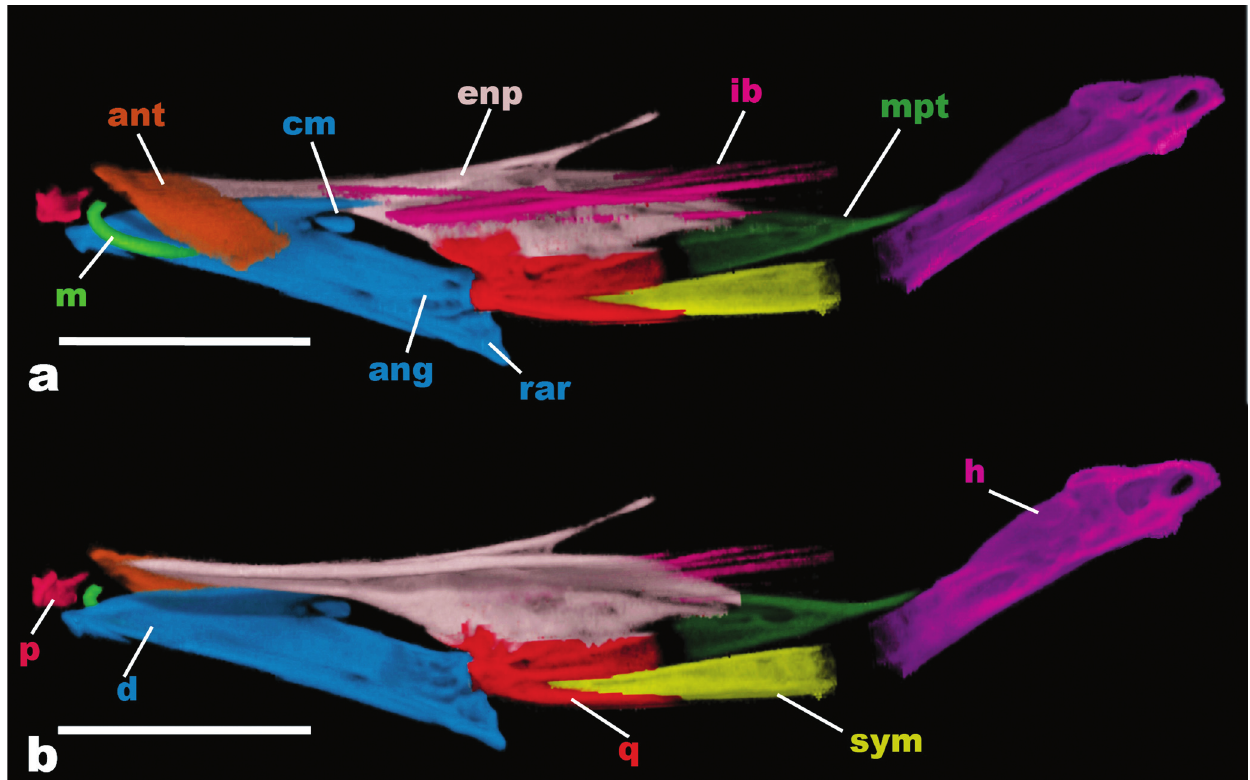
Fig. 5. Suspensorium and oral jaws of the left side of Iracema caiana (MZUSP 49205, 235 mm SL). ( a ) Lateral view; ( b ) Midsagittal view. Anterior to left. Scale bar is 5 mm. Abbreviations: p = premaxilla; m = maxilla; ant = antorbital; d = dentary; cm = coronomeckelian bone; ang = anguloarticular; rar = retroarticular; enp = endopterygoid; q = quadrate; ib = intermuscular bones of adductor mandibulae ; sym = symplectic; mpt = metapterygoid; and h =